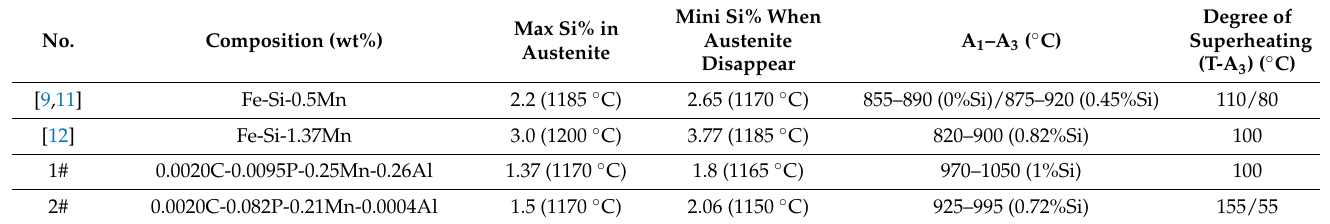
Table 3. Composition of steels and their key Si contents and A 1 and A 3 temperatures.